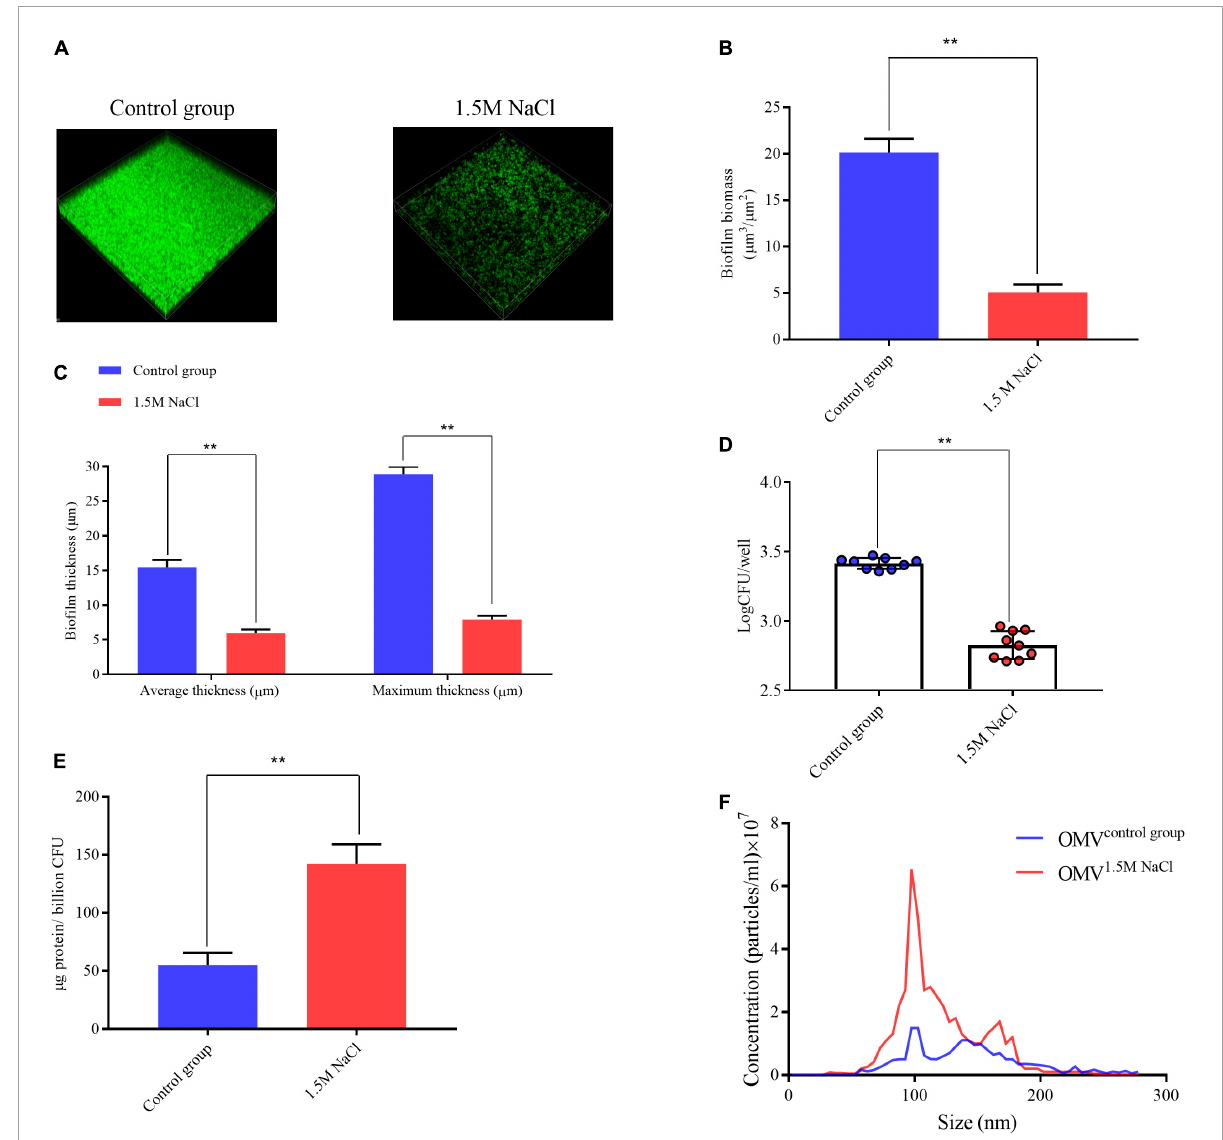
FIGURE2 Brucella melitensis 16M biofilm under 1.5 M NaCl and control conditions. (A) Live confocal imaging of stacks of B. melitensis 16M-GFP biofilms grown for 20 days in Brucella broth medium with or without 1.5 M NaCl. Scale bars = 20 µ m. Confocal images were subjected to quantitative analysis using the Comstat2 program to determine the biofilm biomass (B) and the average and maximum biofilm thickness (C) . (D) Survival of bacteria in biofilms grown with or without 1.5 M NaCl treatment. Mean values in each treatment group were statistically compared using a two-tailed unpaired t -test. Data are representative of at least five biological replicates, with each point representing a biological replicate. (E) Purified OMV were quantified by the modified Lowry assay and normalized to micrograms protein per billion CFU. (F) Nanoparticle tracking analysis measurement of OMV preparation (0.1 mg protein/mL) showing the sizes and total number of OMV per mL. Error bars represent standard error ( n ≥ 3). ** P ≤ 0.01, unpaired Student’s t